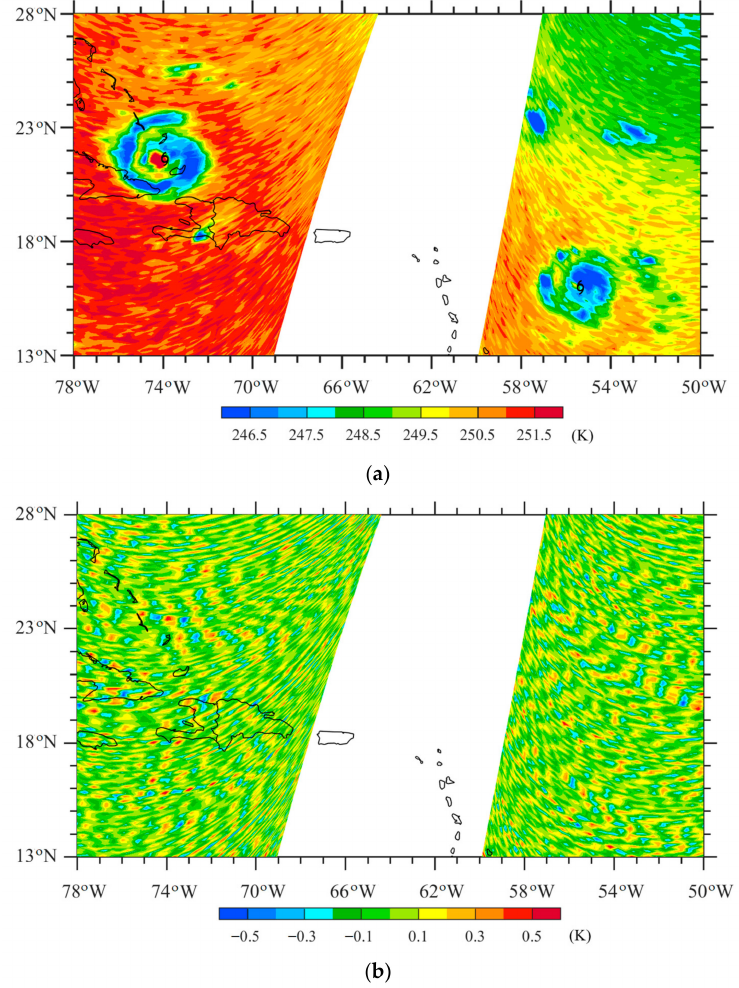
Figure 12. ( a ) TB observations and ( b ) the detected noise at channel 3 from 0721 UTC to 0910 UTC 8 on September 2017 after noise mitigation. Hurricane Irma, located at (21.6 ◦ N, 73.9 ◦ W), had a category H4 intensity, and Hurricane Jose, located at (15.9 ◦ N, 55.3 ◦ W), had a category H3